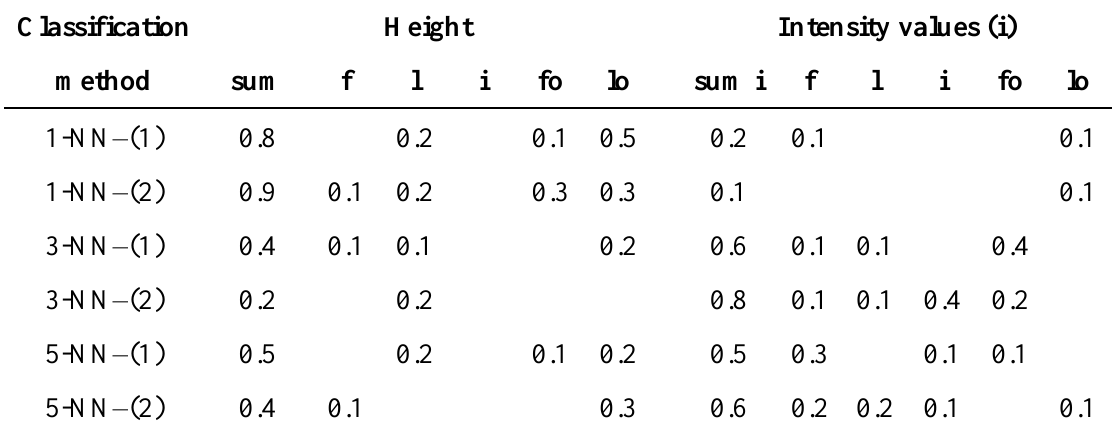
Table 3. Weights of variable distributions used in the k-NN method with 1, 3 and